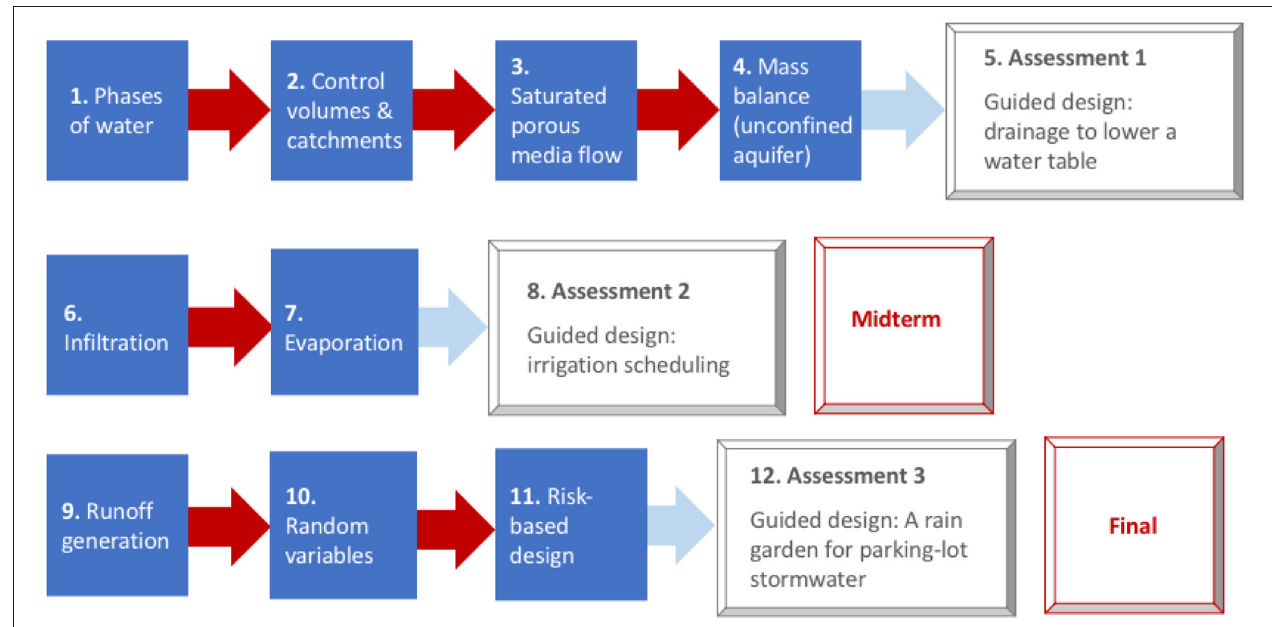
FIGURE 1 | Modular course structure in Engineering Hydrology . Numbers indicate the week in the semester (12 teaching weeks). Red arrows indicate points where access to subsequent course content required passing an ungraded quiz on previous content. Access to materials relating to project-based assessments (blue arrows) was unrestricted. Each course module builds in the previous, culminating in a guided-design assessment. Examination-based additional assessments complement and contrast with the “project-based” assessments.